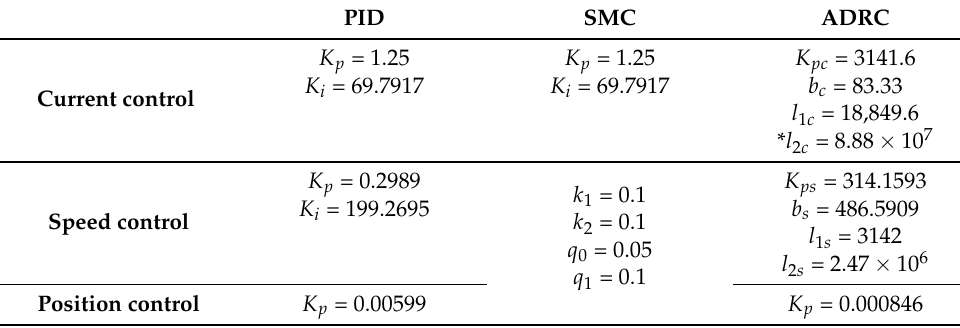
l 1 c = 18,849.6 * l 2 c = 8.88 × 10 7